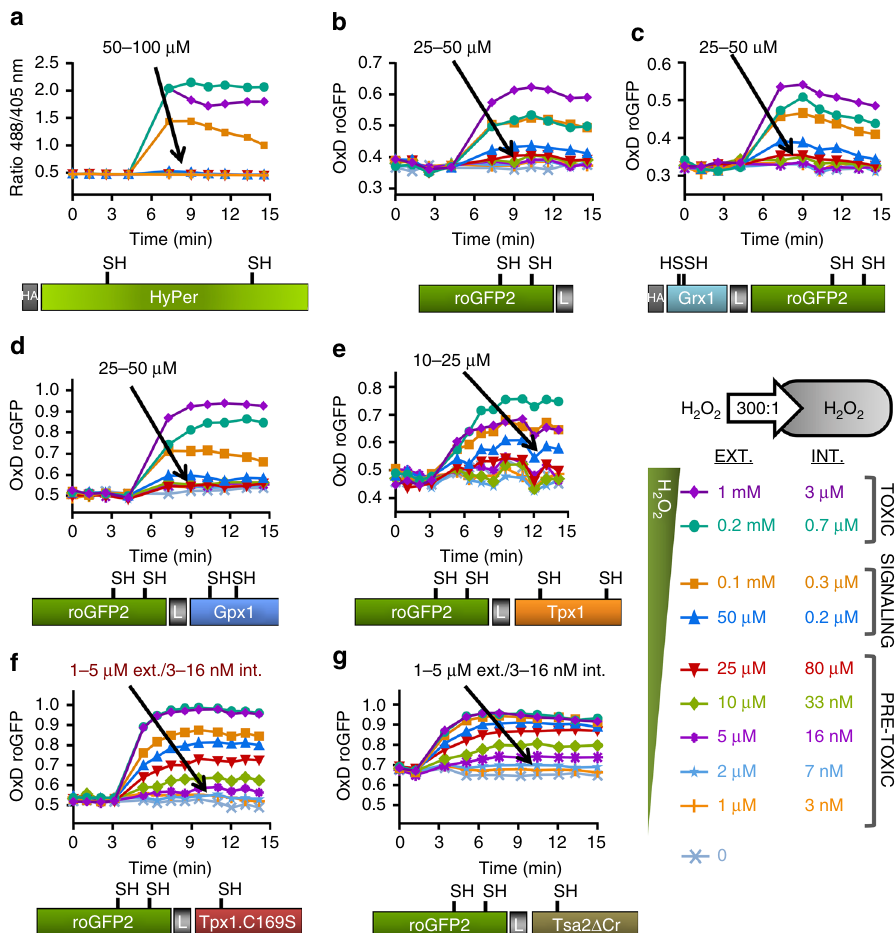
Fig. 1 Oxidation of HyPer and roGFP derivatives upon extracellular H 2 O 2 . Wild-type strain HM123 was transformed with plasmids p605, p406, p379, p429, p407, p407.C169S, and p676, to express HyPer ( a ), roGFP2 ( b ), Grx1-roGFP2 ( c ), roGFP2-Gpx1 ( d ), roGFP2-Tpx1 ( e ), roGFP2-Tpx1.C169S ( f ), and roGFP2- Tsa2 Δ C R ( g ), respectively. The indicated extracellular (EXT.) concentrations of H 2 O 2 , classi fi ed into ‘ Toxic ’ (able to temporarily halt growth), ‘ Signaling ’ (capable to trigger the antioxidant Pap1 cascade) or ‘ Pre-toxic ’ (unable to activate Pap1), were directly added to MM cultures at an OD 96-well imaging plates, and growth proceeded at 30 °C with shaking. The corresponding intracellular peroxide concentrations, after applying a 300:1 membrane gradient, are also indicated (INT.). The degree of probe oxidation (amount of probe oxidized per 1) is indicated in the Y axis (OxD roGFP2), except for HyPer ( a ), for which the ratio 488/405nm is shown. For each panel, data from three biological replicates are shown, with error bars (S.D.) displayed in Supplementary Fig.